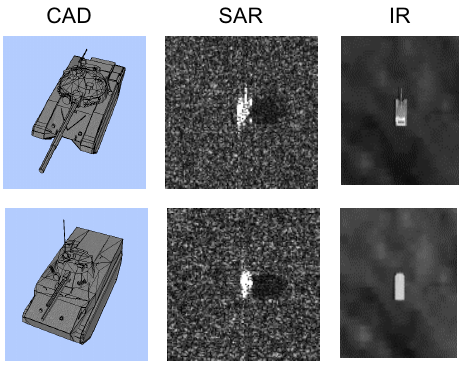
Figure 19. Examples of SAR and IR target generation using